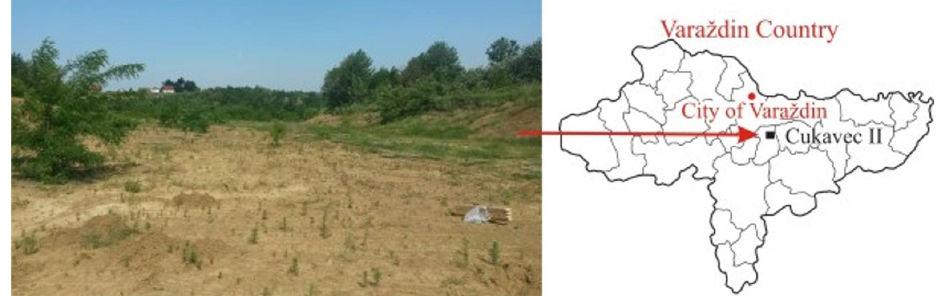
Figure 1. The geographical position of the Cukavec II [4]. The structure of the deposit is dominated by kaolinite, quartz, feldspar, and chlorite, and the granulometric composition shows that the mineral raw material contains about 75% clay component, while the rest is silt. The geotechnical properties of the clay soil were determined as part of the research. Cohesion c, internal friction angle φ, and volume weight γ were determined. Cohesion is c = 23.4 KN/m 2 , internal friction angle φ = 19.8°, and volume weight γ = 18.7 KN/m 3 [4,7]. Spherical cavity blasting is rare in hard rocks. Namely, the effect of smaller explosive charges on spherical cavities is, in principle, dif- ferent than continuously filled boreholes in mining and blasting operations. Detonation of smaller explosive charges crushes the material in proximity of the activated explosive charge. With the increased distance from the explosive charge, the released energy is not enough for crushing materials but still impacts it [4,11,12,14]. Test blasts were performed with 48 blast holes 131 mm in diameter and with a hole depth of 2.0–3.0 m. Two types of civil explosives were used: ANFO explosive Pakaex and ammonium nitrate powder explosive Permonex V19. The harge mass varied from 0.2 up to 1.6 kg. Explosive charge activation was performed with a nonelectric initiation system, and the stemming length was 0.5 m, composed of 0/4 mm grain sand. Explosive mass per borehole charge has been determined according to previous research, and presented data for boreholes MB 37 and MB 22 represent application to function. The expansions gener- ated by the explosive charges on the Cukavec II were different in shape and size. The spherical expansion was obtained with explosives Permonex V19 and Pakaex. Table 1 shows the specifications from the manufacturer of Pakaex and Permonex V19. Table 1. Specifications from the manufacturer of Pakaex and Permonex V19 [4,6,14,17,18,22]. Pakaex 4.2 A method has been developed to determine the shape and calculate the resulting expansion volume, which is an integration of the GNNS method [4,6,17,18,23–25], a bore- hole camera [26], and a laser (Figure 2) [27].